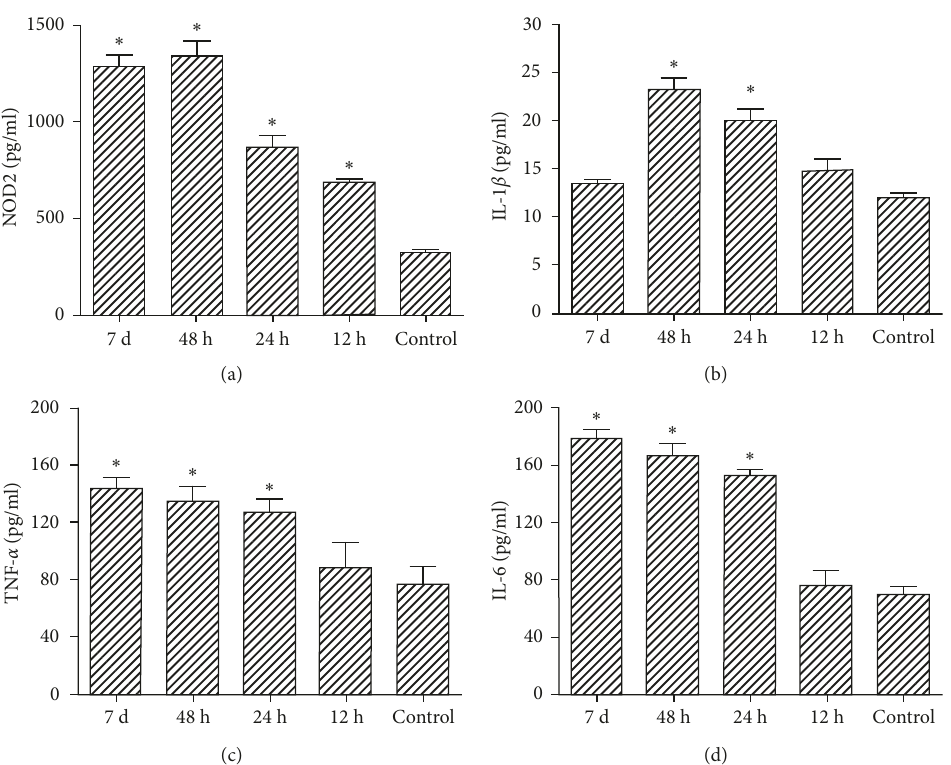
Figure 1: NOD2 and inflammatory factor expression levels in brain tissue at different time points (0, 12, 24, and 48 h and 7d). Evaluated factors are NOD2, IL-1 β , TNF- α , and IL-6. Data are mean difference versus control group considering a p value